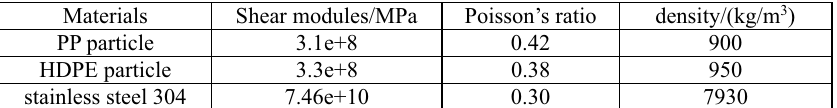
Table 2. Physical parameters of